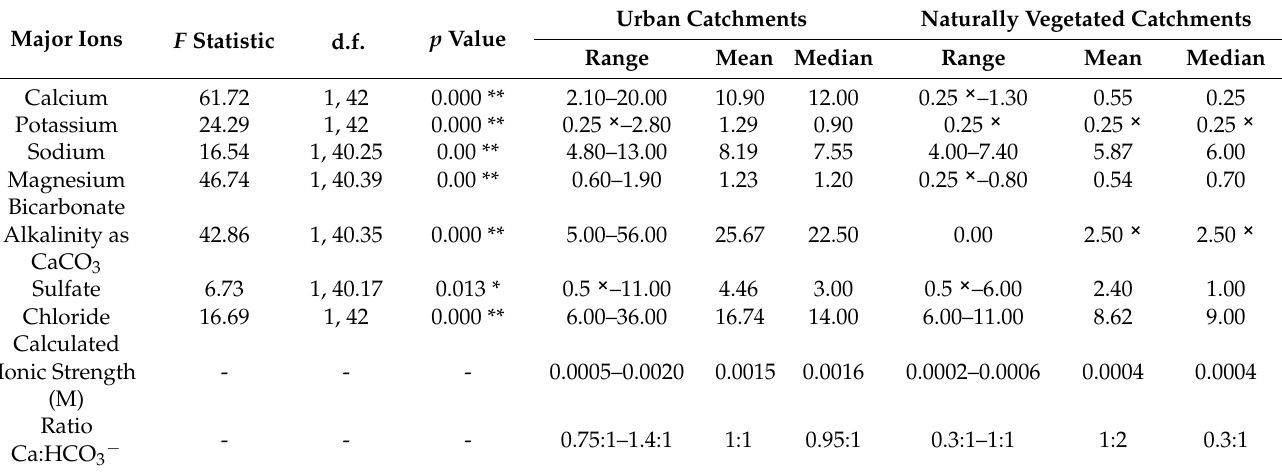
denotes values that were below the detection limit. d.f. refers to degrees of freedom (numerator, denominator) and—indicates that statistical analysis was not required for the attribute. Units for ionic strength are in Moles (M).